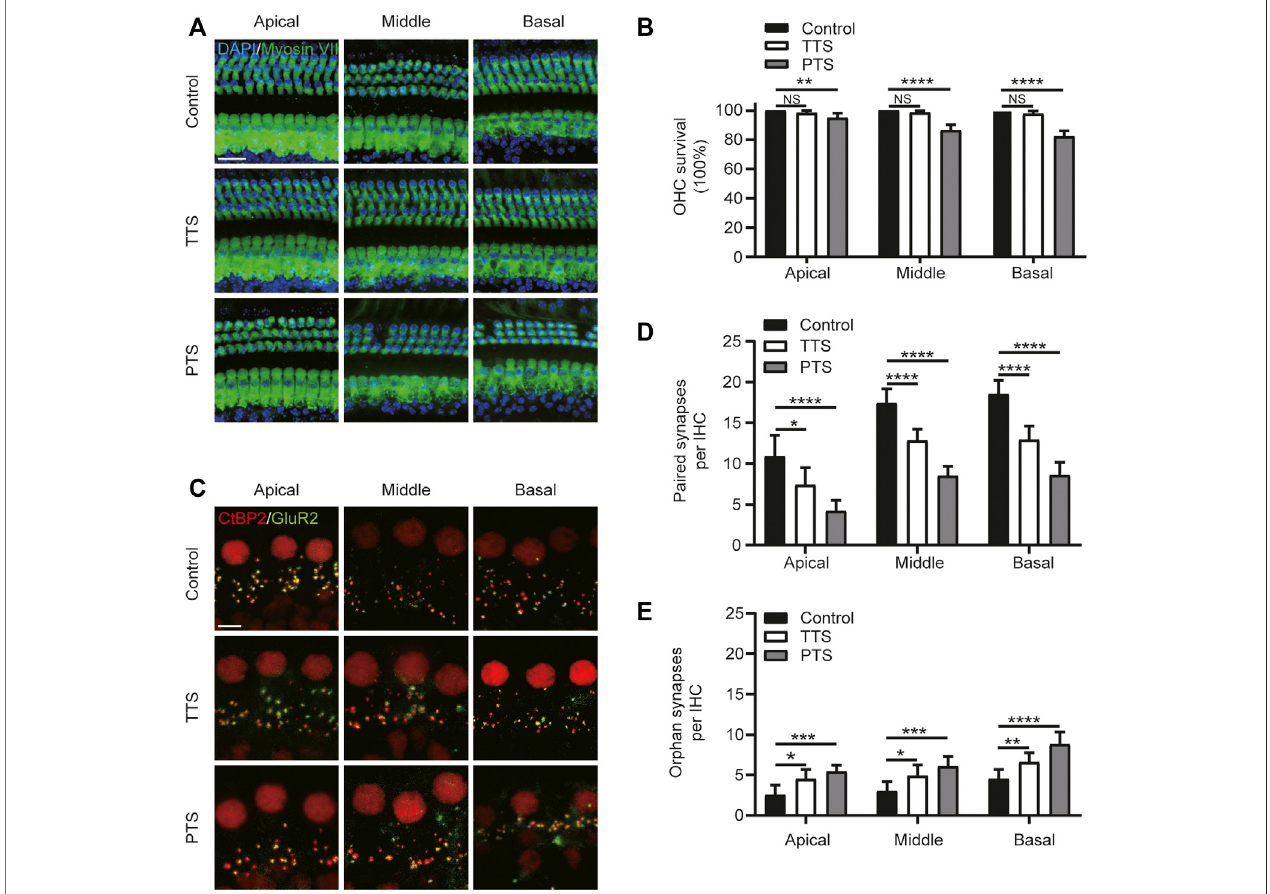
FIGURE 2 | Morphological alterations of mice in the PTS and TTS groups. The basilar membrane was divided into apical, middle, and basal turns for separate observation. (A) Immunohistochemicalstainingshowingchangesinthenumberofhaircells(MyosinVII,green;DAPI,blue)inthePTSandTTSgroups. (B) Quanti fi cation of Myosin VII and DAPI-positive HCs. (C) Immunohistochemical staining showing changes in the number of presynaptic (CtBP2, red) and postsynaptic structures (GluR2, green) in the IHCs ofthe PTS and TTSgroups. (D) Quanti fi cation ofCtBP2 and GluR2 overlapping fl uorescentspots. (E) Quanti fi cation of CtBP2 or GluR2 fl uorescent spots alone. ( n (cid:1) 10 per group). TTS, temporary threshold shift; PTS, permanent threshold shift; DAPI, 4, 6-diamidino-2-phenylindole; OHC, outer hair cell, IHC, inner hair cell. NS, not signi fi cant; * p < 0.05; ** p < 0.01; *** p < 0.001; **** p < 0.0001. Scale bars: A, 20 μ m; C, 5 μ m.